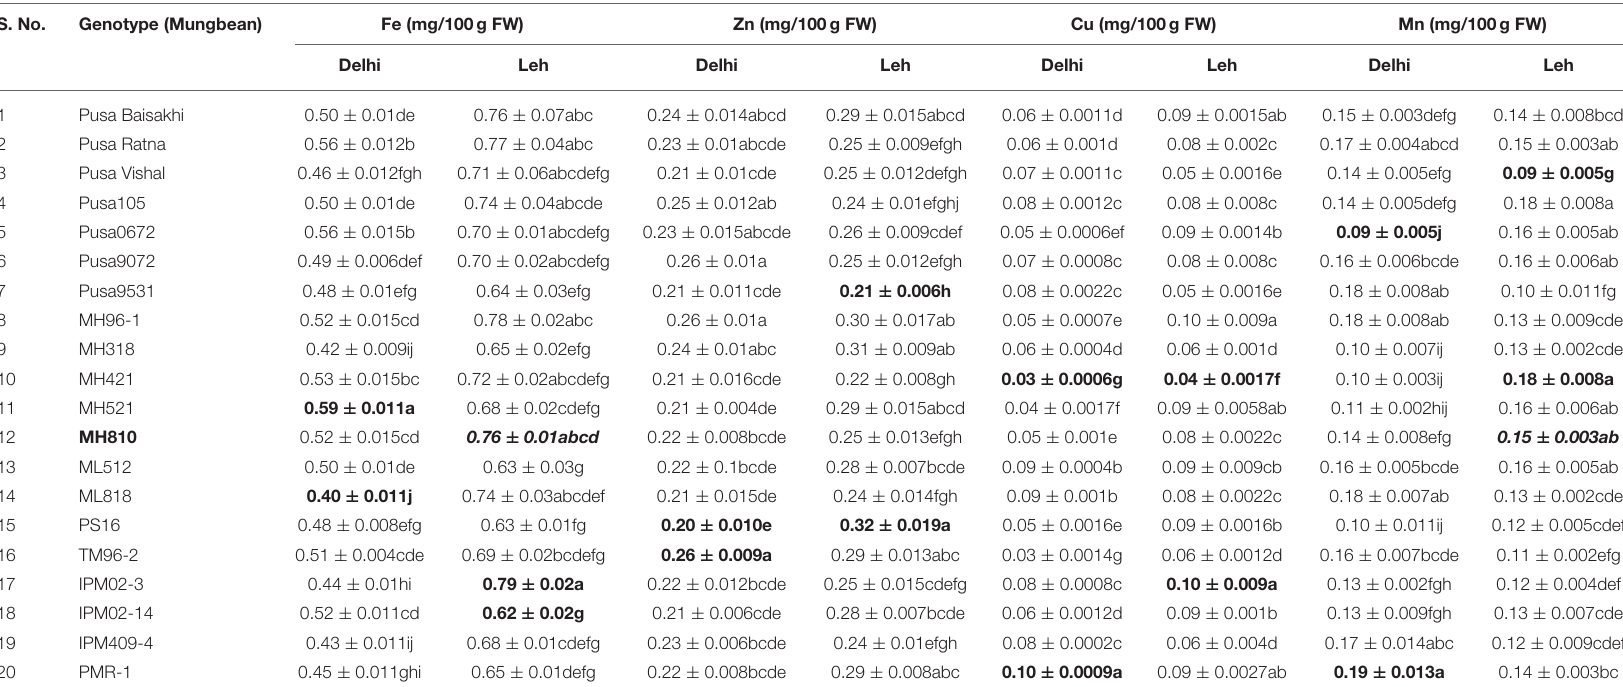
Values are expressed as mean ± SD (n = 3), and different letters indicate a significant difference (p ≤